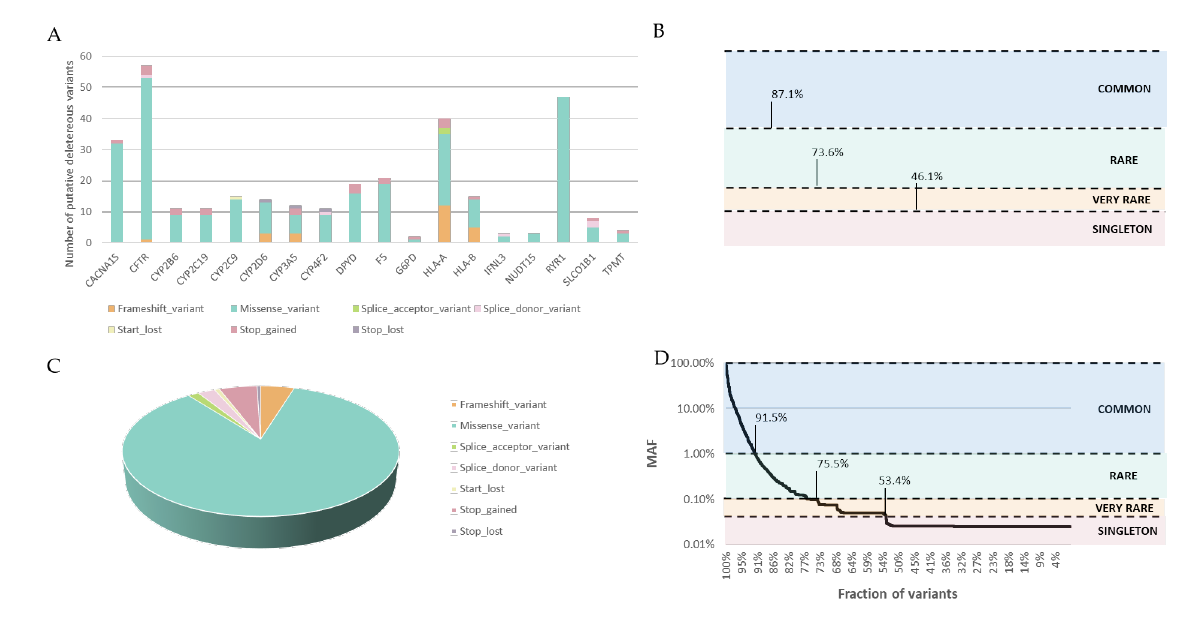
Figure 3. Putative deleterious variants identified in the 2046 individuals from exome and genome data. ( A ) Distribution of the putative deleterious variants identified in the 21 pharmacogenes categorised as level 1A in the PharmGKB database according to their consequence (Table S7). ( B ) Distribution of the variants identified in the 21 pharmacogenes categorised as level 1A in the PharmGKB database according to their MAF. Rare variants (MAF < 0.1%) and very rare variants (MAF < 0.01%) account for 87.1% and 73.6%, respectively, and 46.1% were identified only in one individual (singleton). ( C ) Distribution of the putative deleterious variants identified in the 1045 pharmacogenes included in the PharmGKB database according to their consequence (Table S8). ( D ) Distribution of the variants identified in the 1045 pharmacogenes included in the PharmGKB database according to their MAF. Rare variants (MAF < 0.1%) and very rare variants (MAF < 0.01%) account for 91.5% and 75.5%, respectively, and 53.4% were identified only in one individual